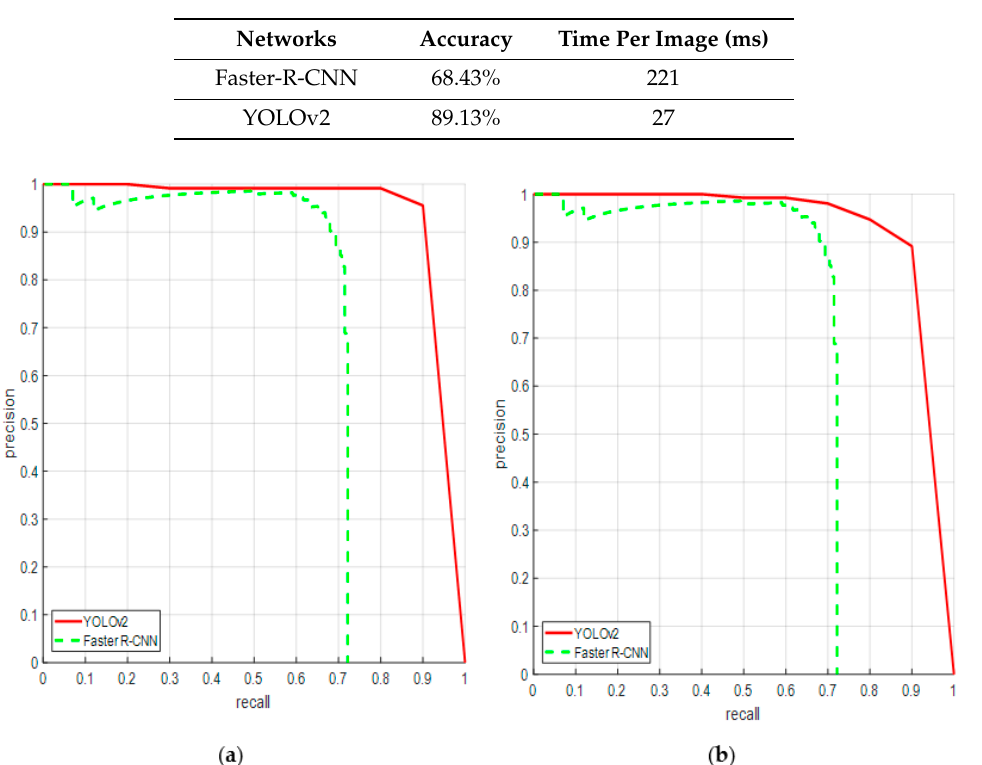
Figure 8. ( a ) Precision recall curve performance of ship detection on SSDD ( b ) Precision recall curve performance of ship detection on the DSSDD